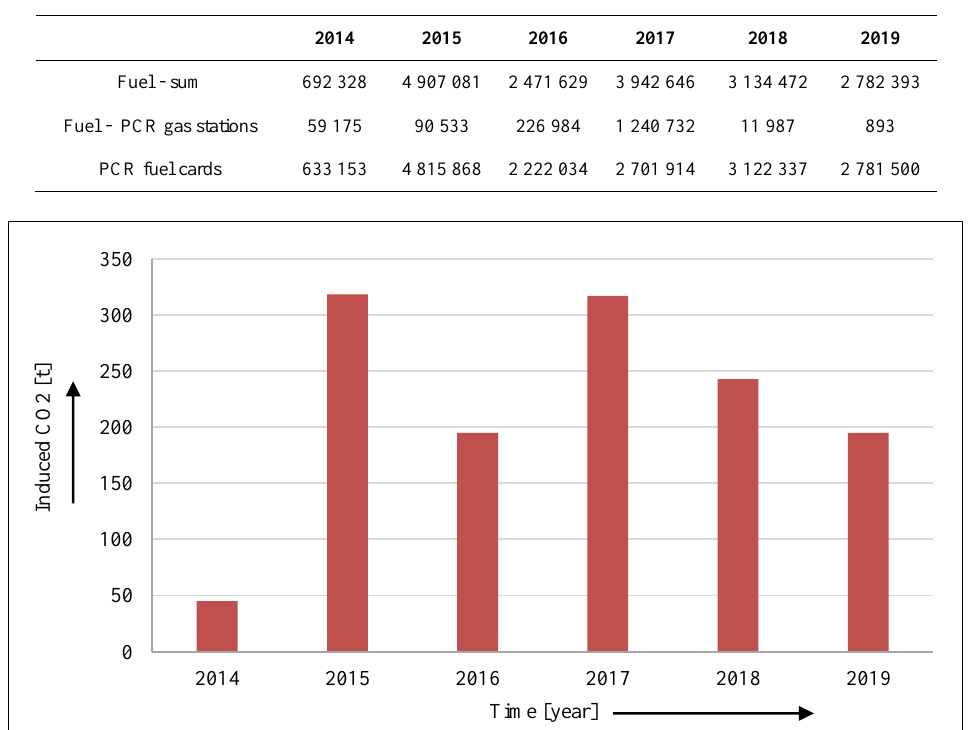
Table 5. Expenditures of the PCR for fuels in 2014-2019 in CZK [54]